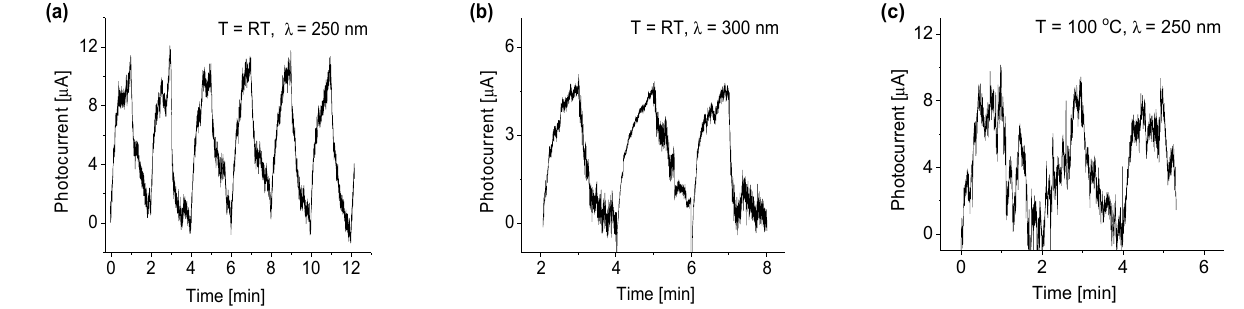
Figure 7. N-UNCD UV responses to ( a ) 250 nm, ( b ) 300 nm when the sensor was operated at room temperature, and ( c ) 250 nm operated at 100 °C. The bias of 1 V and light intensity of 1 mW/cm 2 remained unchanged for all cases.